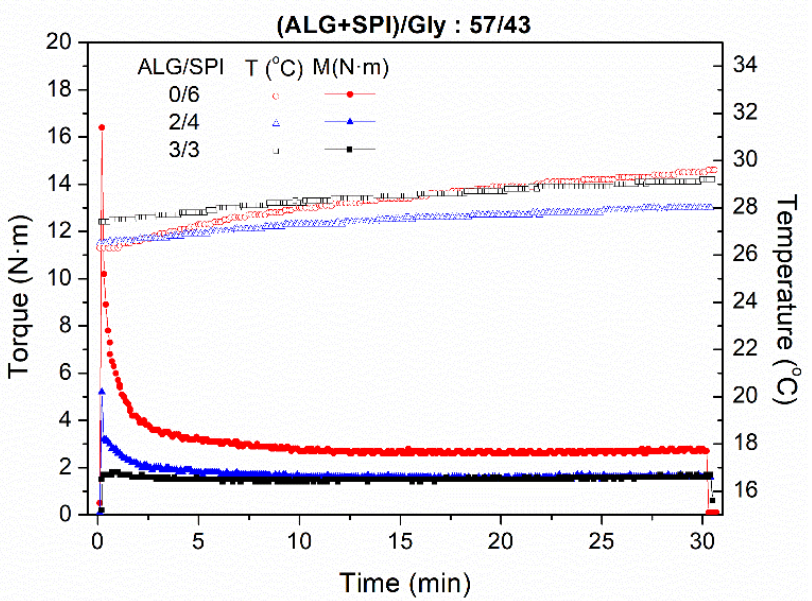
Figure 1. Torque and temperature evolution within the mixer cavity during the mixing stage for alginate (ALG) + soy protein isolate (SPI)/glycerol blends with different ALG/SPI ratios.